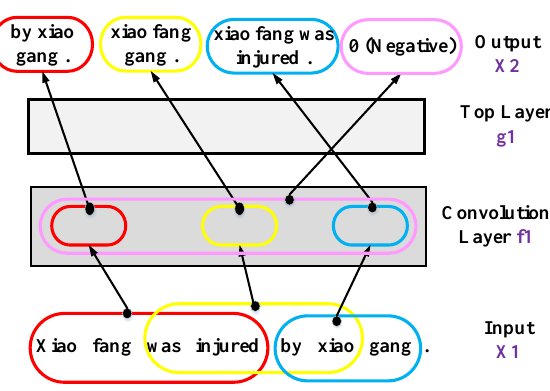
Figure 5. Two-view (tv)-embedding learning by training to predict adjacent